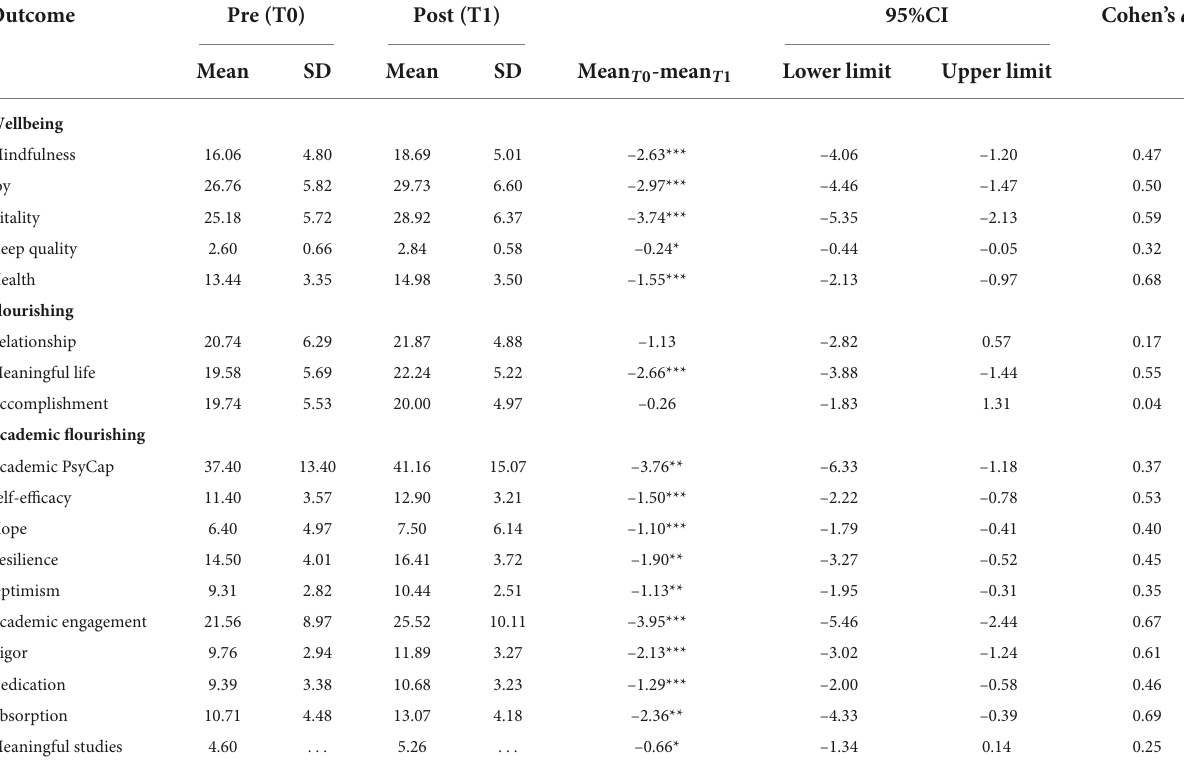
TABLE 3 Results of t -test between pre (T0) and post (T1) measures ( N =